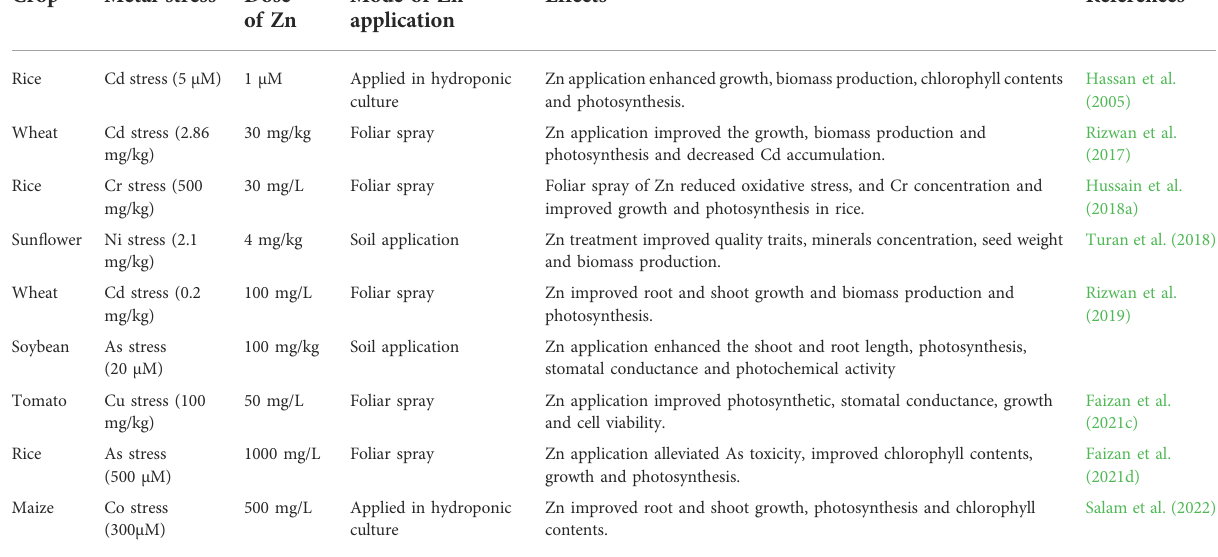
TABLE 3 Effect of Zn on growth and physiological functions different of crops under metal stress